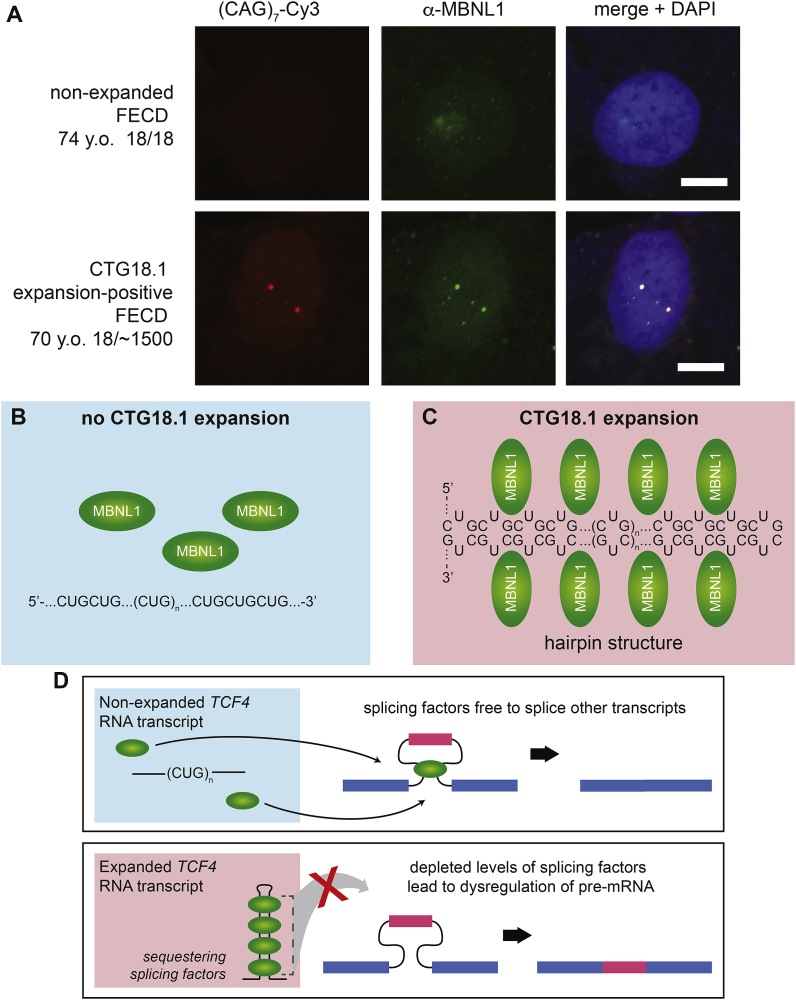
Sequestration of MBNL1 to RNA foci within corneal explant tissue. A. MBNL1 is sequestered to the RNA foci within the corneal endothelium of only CTG18.1 expansion-positive FECD patient-derived tissues, scale bar 5 μM. B. Schematic illustrating that in the absence of CTG18.1 expansions, MBNL1 is soluble within the nucleus. C. In the presence of a CTG18.1 expansion, levels of functional MBNL1 are depleted due to the sequestration of the splicing factor to hairpin structures formed by the RNAs comprising expanded copies of TCF4 transcripts. D. Schematic depicting hypothesised mechanism of splicing dysregulation observed within expansion-positive corneal endothelial cells where the sequestering of splicing factors to hairpin structures formed by TCF4 RNA transcripts results in widespread dysregulation of pre-mRNA splicing. Permission for re-use of (A) from Du et al. (2015) was granted through CC-BY license (https://creativecommons.org/licenses/by/4.0/legalcode).